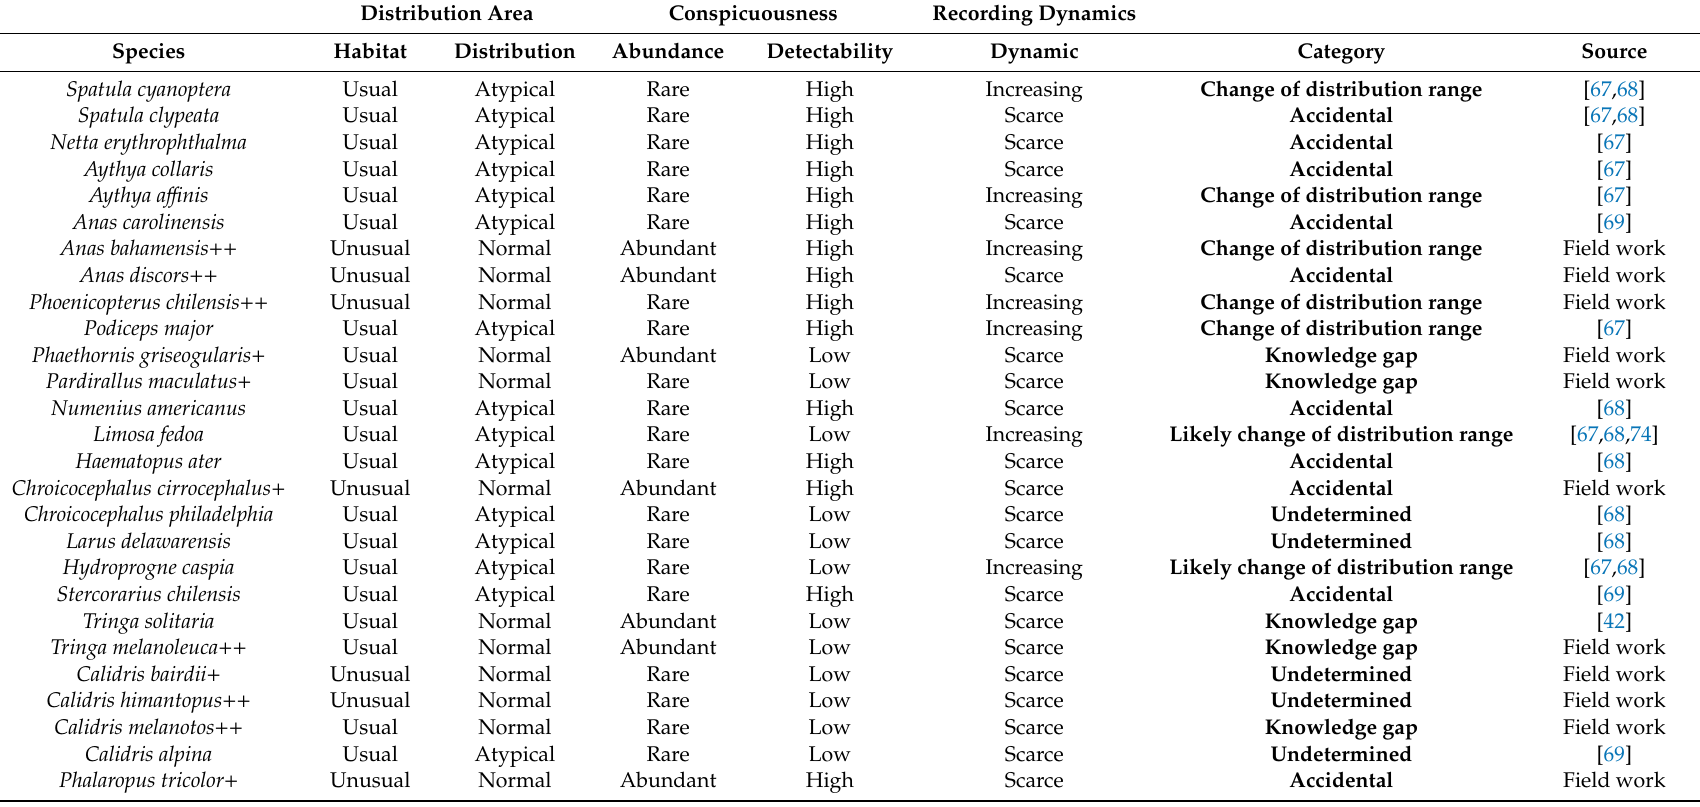
Table A1. Bird species reported as “new records” in the Ecuadorian Tumbesian region in the last two decades (2000–2020). In addition, there were four Palearctic species ( Passer hispaniolensis , Elanus caeruleus , Columba palumbus, and Streptopelia decaocto ) used to validate the methodology. The “ + ” indicates a new species for the Zapotillo canton and the “ ++ ” indicates new species for the Loja